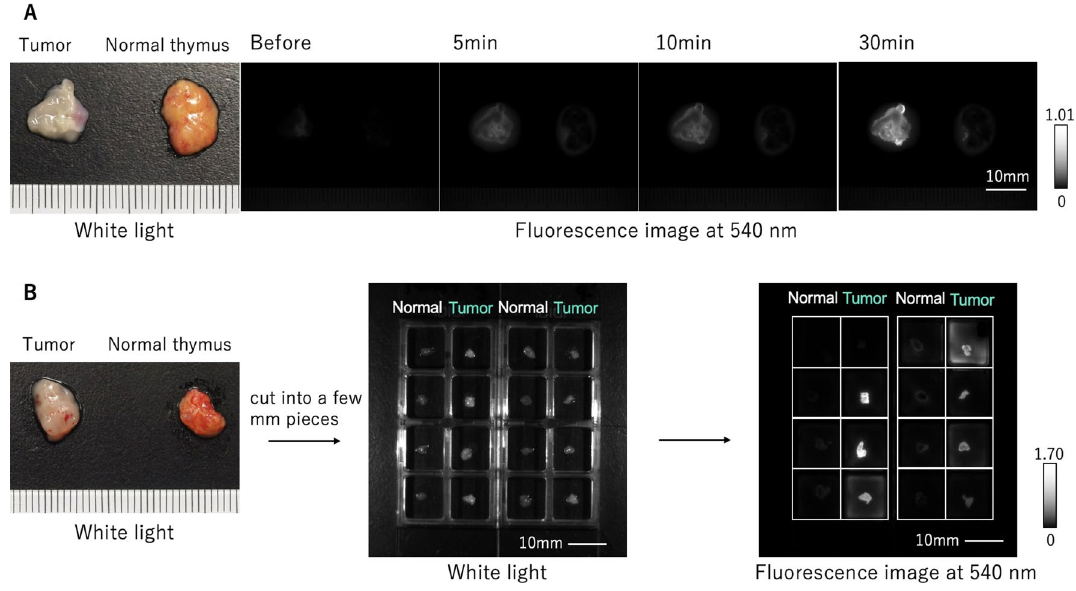
Figure 1. Ex vivo fluorescence imaging of specimens from thymoma and thymic carcinoma patients. A solution of 50 μM gGlu-HMRG was applied to tumor and normal tissue, and images were captured before and at 5, 10, and 30 min after application by Maestro with an appropriate exposure time. The fluorescence image at 540 nm was extracted. Probe solution was prepared with PBS (−) containing 0.5% v/v DMSO as a cosolvent. One graduation on the ruler is 1 mm. ( A ) Ex vivo fluorescence imaging of relatively large specimens of thymic tumor and normal tissues. ( B ) Ex vivo fluorescence imaging of cut pieces of thymic tumor and normal tissues a few millimeters in size.